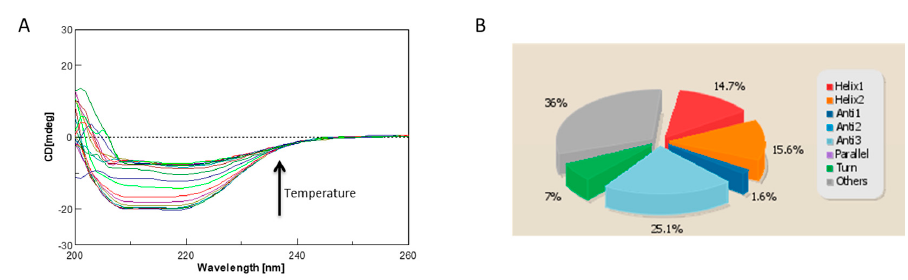
Figure 7. ( A ) CD spectra of Δ TM-FlmC reported as function of temperature; ( B ) Secondary structure content evaluated using the CD data by the server BeStSel.